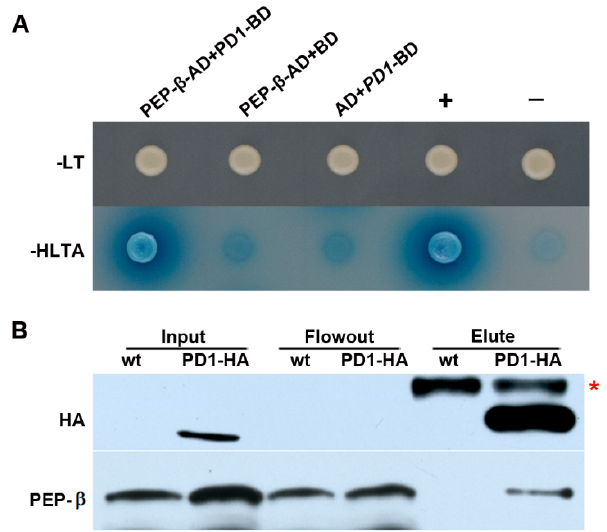
Figure 8. PD1 interacts with PEP- β . ( A ) Yeast two-hybrid assays. The predicted mature PD1 protein fused to the GAL4 DNA-binding domain (BD) was expressed in combination with PEP- β proteins fused to the GAL4 activation domain (AD) in yeast strain AH109. Cells were grown on different selective media. Empty BD and AD vectors served as negative controls. -LT, SD medium without Leu and Trp; -HLTA, SD medium lacking His, Leu, Trp, and Ade. X- α -Gal was added to -HLTA plate to indicate the expression of the MEL1 reporter gene. +, Positive control expressing pGADT7-T and pGBKT7-53 ; − , Negative control expressing pGADT7-T and pGBKT7-Lam . ( B ) Coimmunoprecipitation assay. Total leaf protein extracted from two-week-old wild type and transgenic seedlings expressing PD1-HA tag fusion protein received CoIP assay by employing Anti-HA-tag mAb-Magnetic Beads. The samples of input, flowout, and elute were examined by specific antibodies for HA and PEP- β , respectively. The asterisk shows a nonspecific band.